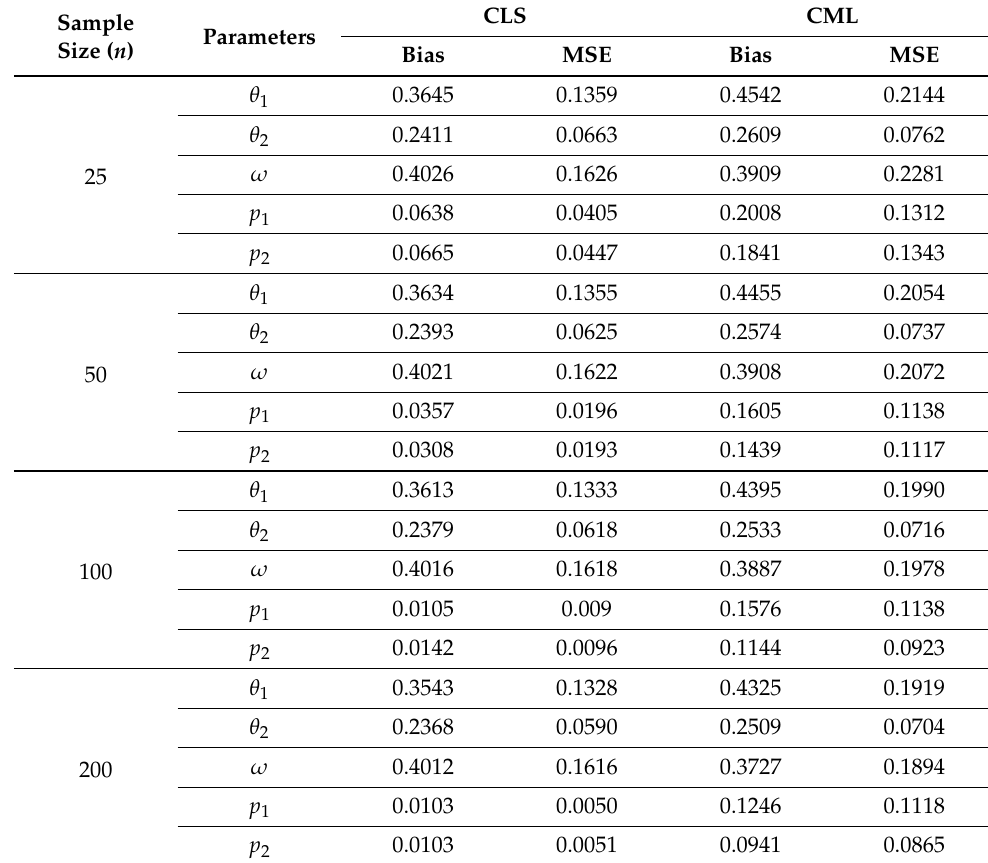
Table 5. Simulation results for the BINAR(1)BP2S-L(II) process for the set of parameter